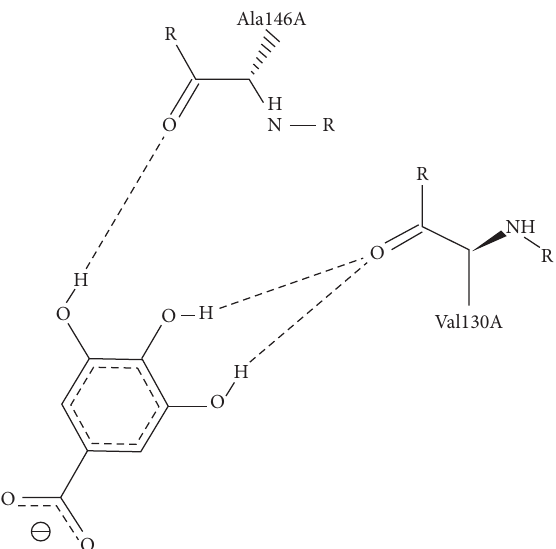
Figure 3: 2D interaction models in the active site of Bcl-2 protein and compound